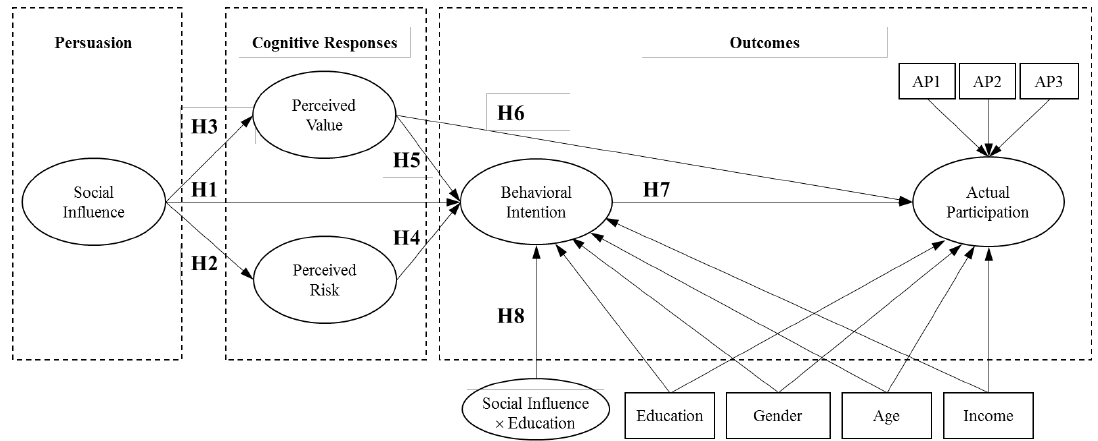
Figure 1. Research Model. H = Hypothesis. AP = Actual Participation